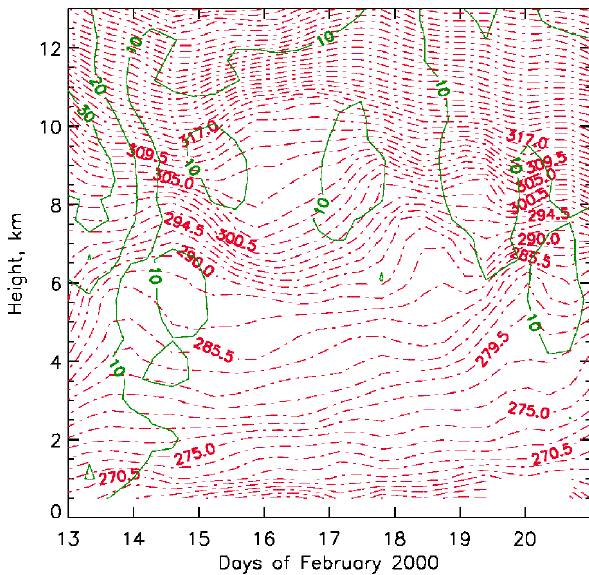
Fig. 4. Time series of potential temperature (red) and wind speed (green) at